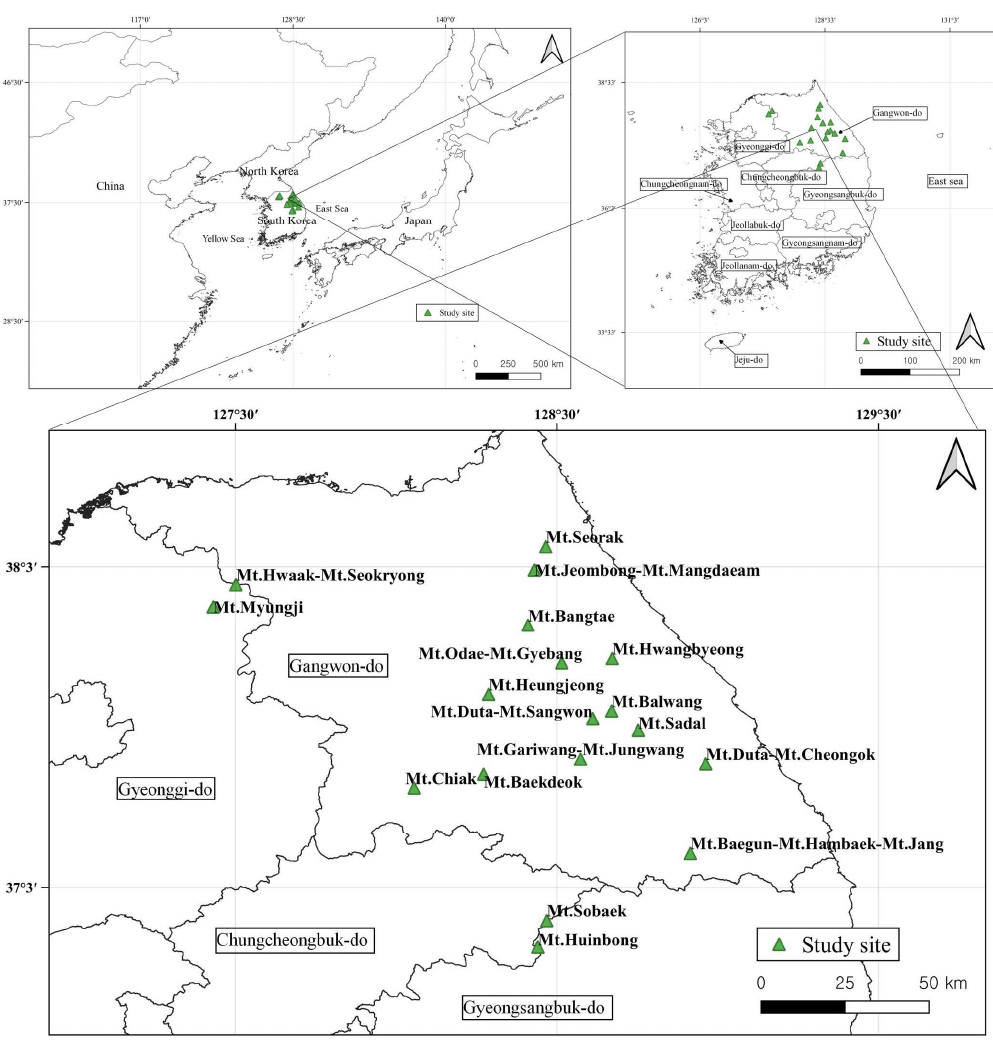
Figure 1. The location of the study sites.